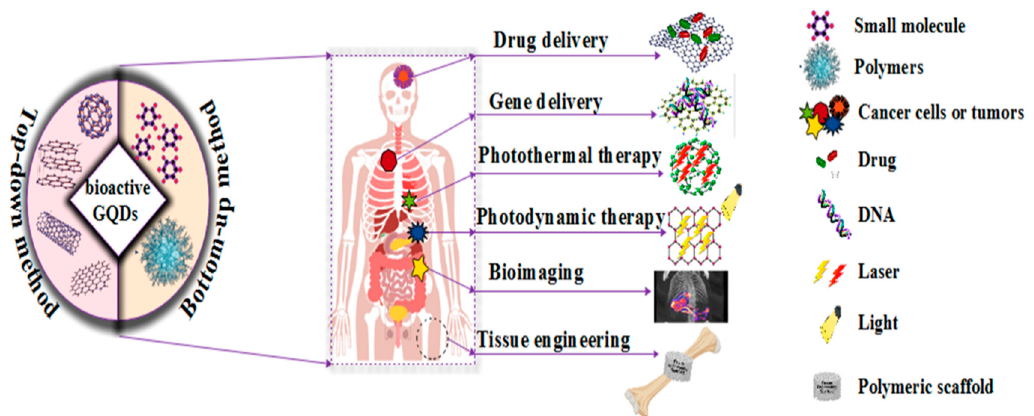
Figure 1. The applications of bioactive GQD-based polymer composites in biomedicine.